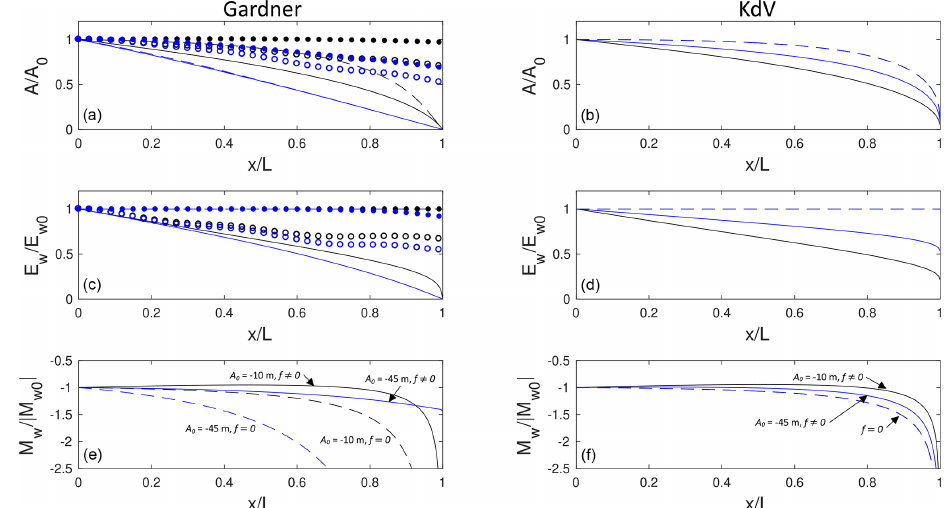
Figure 8. Adiabatic theory for wave propagation from deep to shallow in a two-layer system with h 1 = 100m, h 20 = 200m, g (cid:48) = 0 . 01ms − 2 , f = 10 − 4 s − 1 , and L = 40km. Panels (a, c, e) show A/A 0 , E w /E w0 and M w / | M w0 | , for the rotating Gardner theory. The solid (dashed) lines are with (without) rotation for A 0 = − 10m (black) and − 45m (blue). The open (solid) symbols are from the corresponding numerical solutions of Eq. (3) with (without) rotation. Panels (b, d, f) show the equivalent rotating KdV adiabatic solutions.